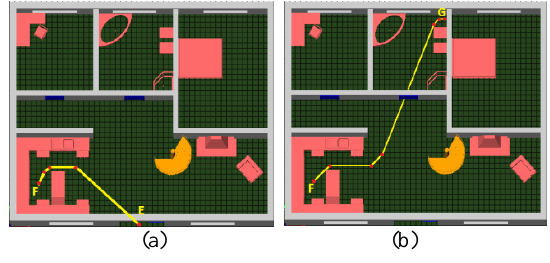
Figure 7. Comparison of computational time, path length and error with different grid count